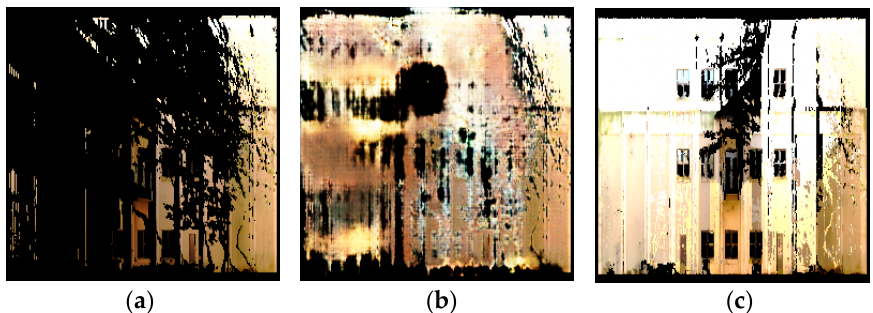
Figure 17. Example of a Pix2Pix limitation: ( a ) input, ( b ) building facade after applying Pix2Pix, and ( c ) target ground truth.